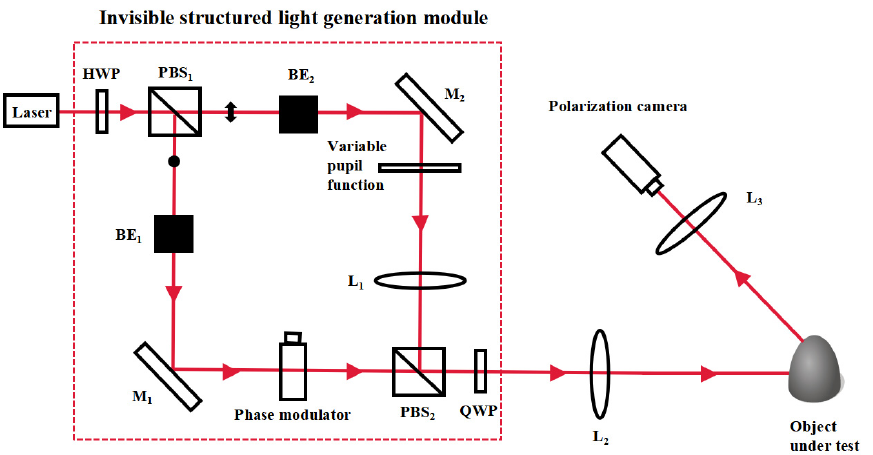
Figure 1. Invisible structured light 3D imaging system. HWP: half wave plate; QWP: quarter wave plate; PBS 1 , PBS 2 : polarization beam splitter; BE 1 , BE 2 : beam expander; M 1 , M 2 : mirror; L 1 , L 2 , L 3 : lens.